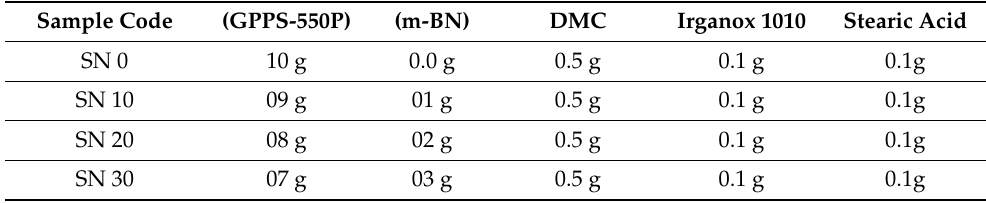
Table 2. Sample codes and details of